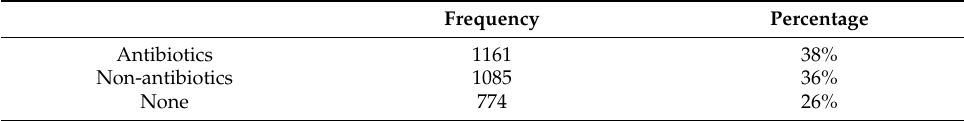
Table 4. Medicine used before physician visit.